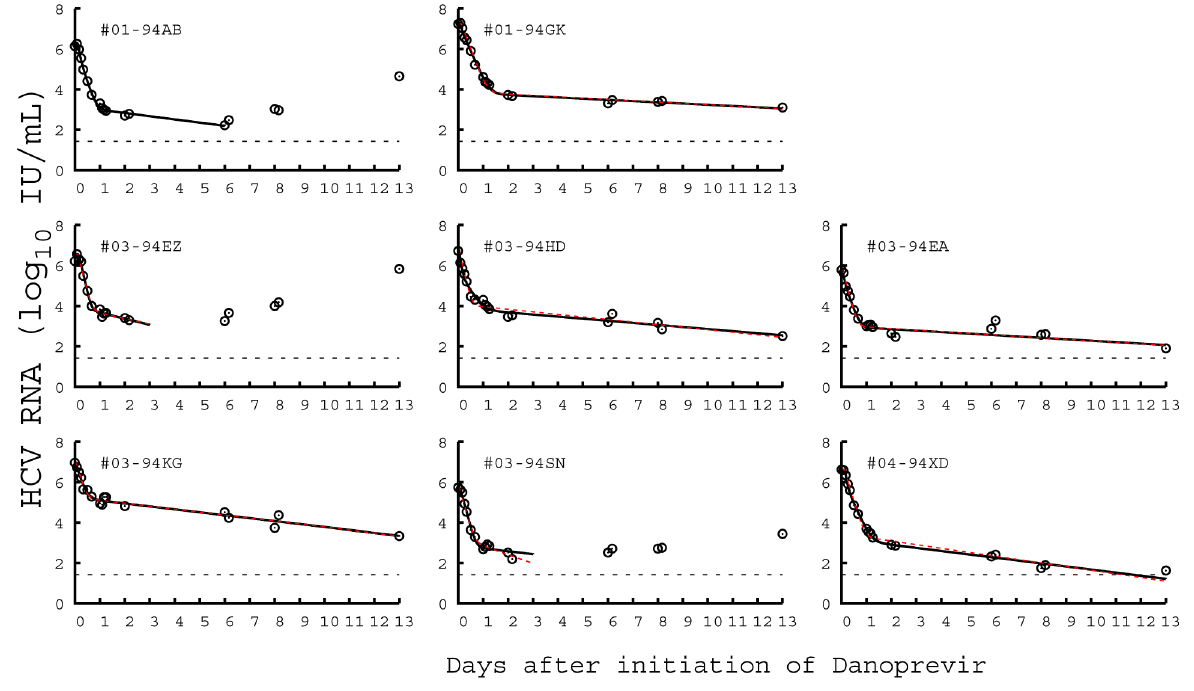
Figure 1. Comparison of viral load data with model predictions for each patient. The prediction from the standard biphasic model is shown by the red dashed line and the prediction from the long-term approximation of the full multiscale model is shown by the black solid line. In most cases the two predicted viral load decay curves overlap and cannot be distinguished. The parameter values used to generate the theoretical curves are the best fit values given in Table 1 and 2, respectively. Viral rebounds occur due to drug resistance and the decay data (circles) was only fit until resistance was detected or rebound was observed. The limit of viral load detection is indicated by the black dashed line.